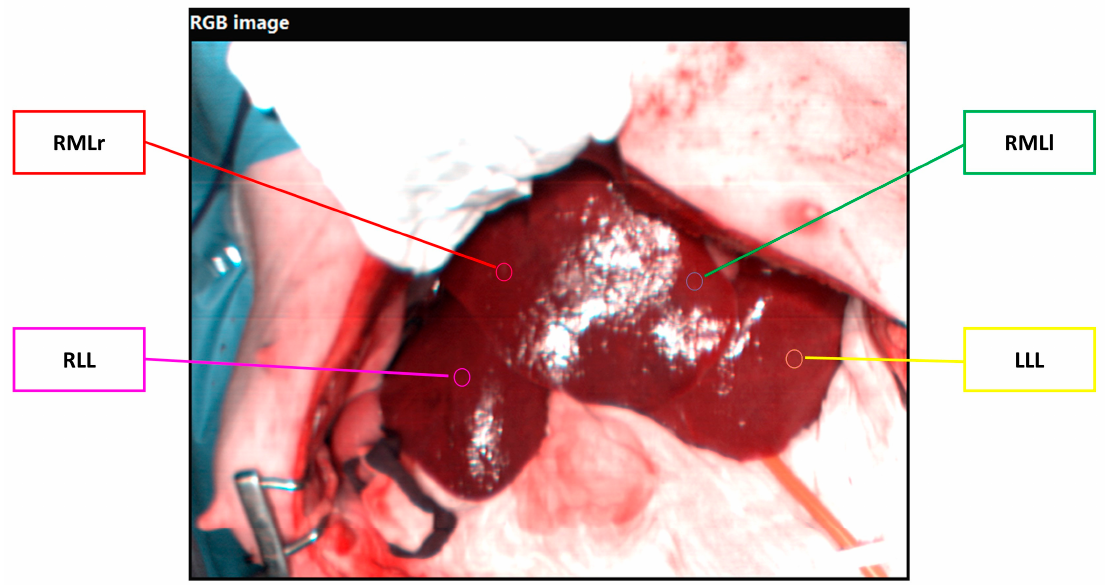
Figure 1. Example of the ROI positioning to extract the indexes.